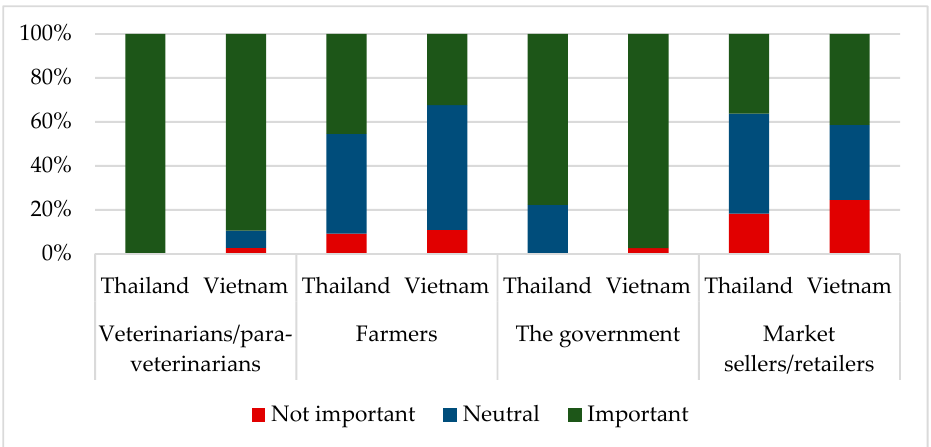
Figure 1. Farmer attitudes to the roles of different actors in monitoring the prudent use of antimicrobials in pigs. Table 6. Farmer volunteered responses to the economic advantages of the use of antimicrobials in pig farms in a case study regarding pig production in Thailand and Vietnam.